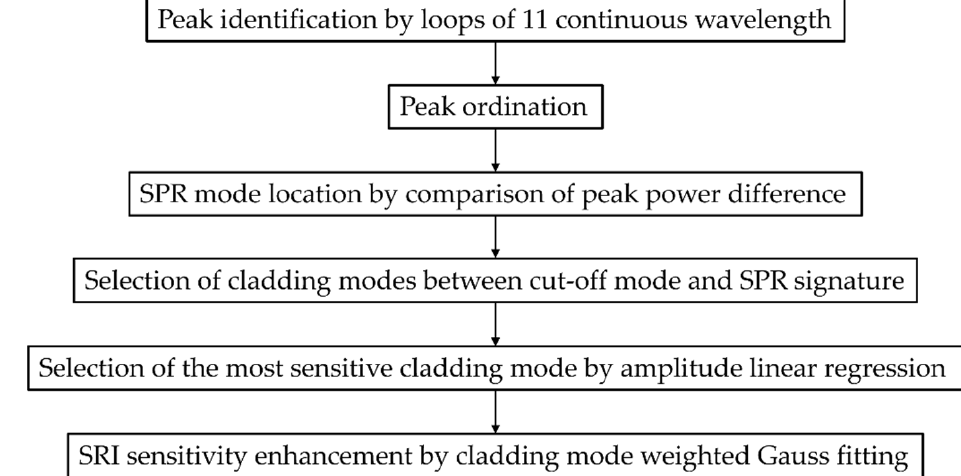
Figure 3. Schematic of SRI demodulation algorithm.